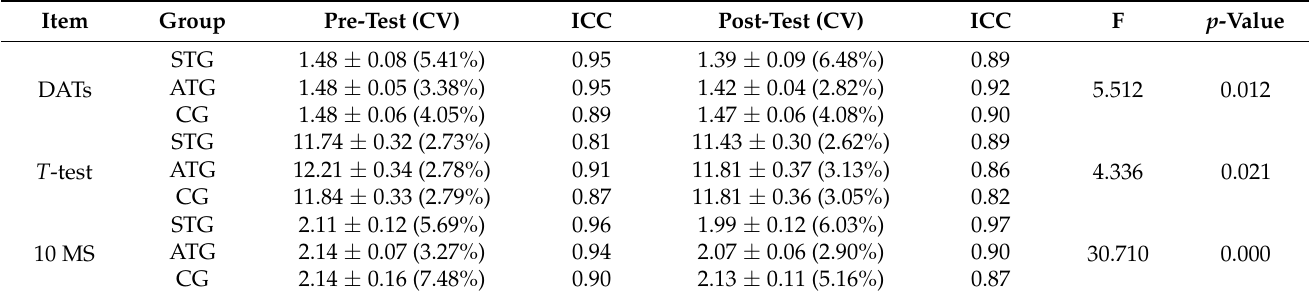
Table 2. The results of DAT, agility T -test, and 10 MS for pre-test and